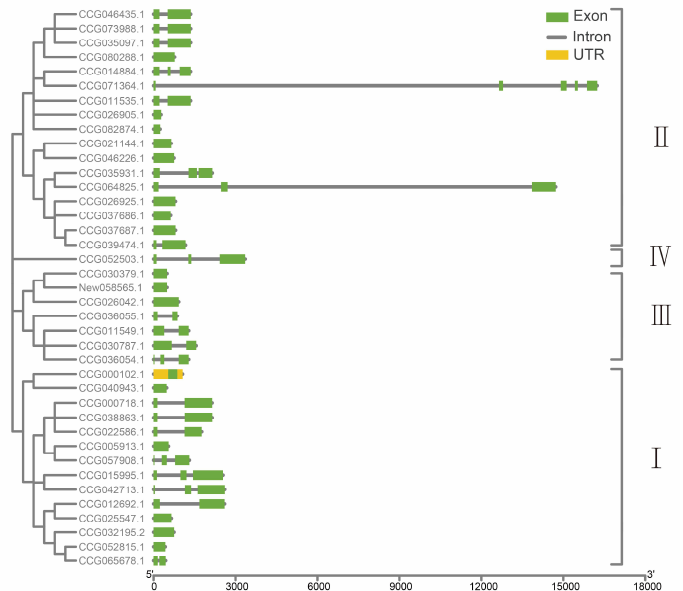
Figure 4. Gene structures of DDE_Tnp_4 family genes in E. sinensis . The green models mean exons, yellow models mean untranslated regions (UTR), and grey lines mean introns.